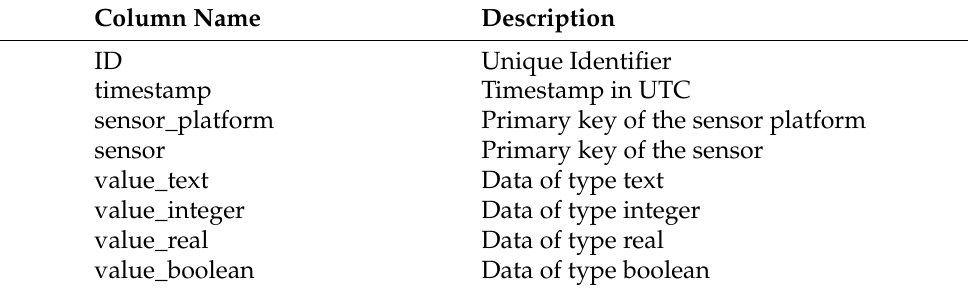
Table 2. Schema of the sensor agnostic data